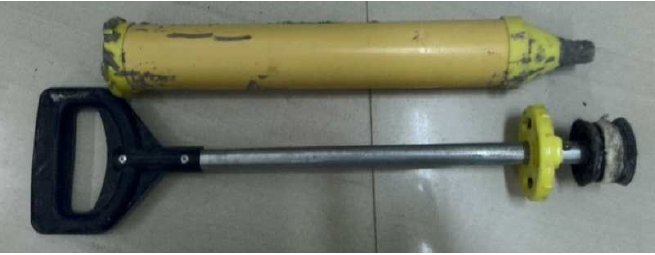
Figure 2. Schematic diagrams of grout sleeve. Table 1. The dimensions of the sleeves.